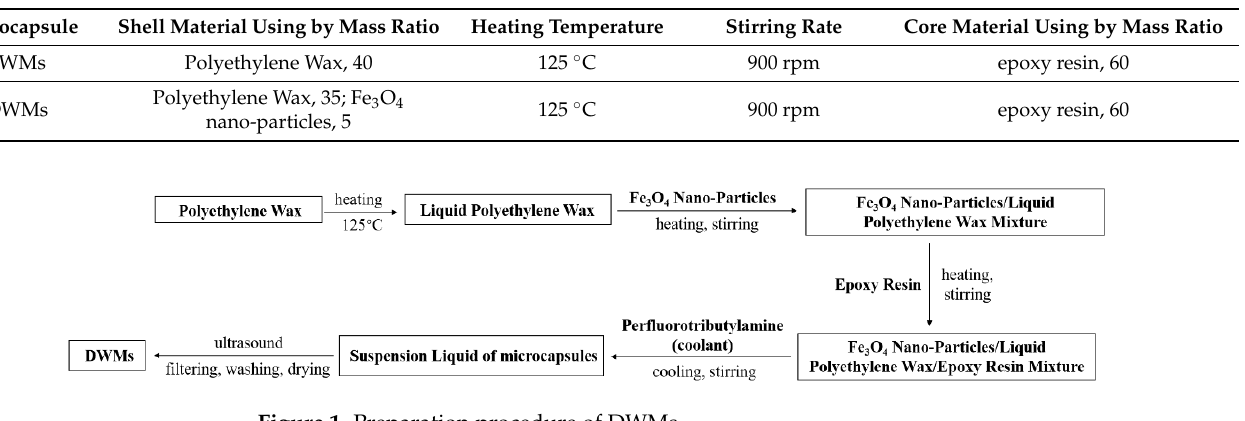
Table 1. Preparation parameters of microcapsules.